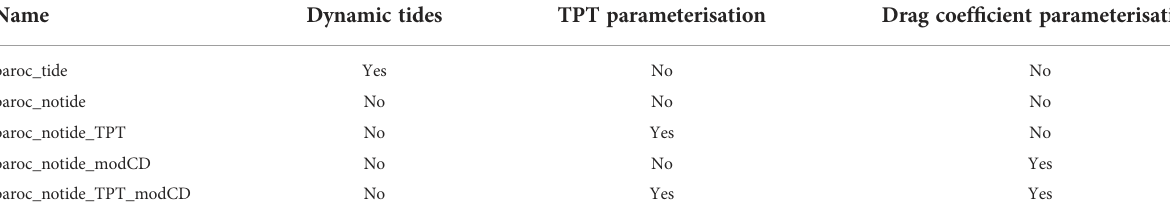
TABLE 3 Summaries of the experiments, including their treatment of the